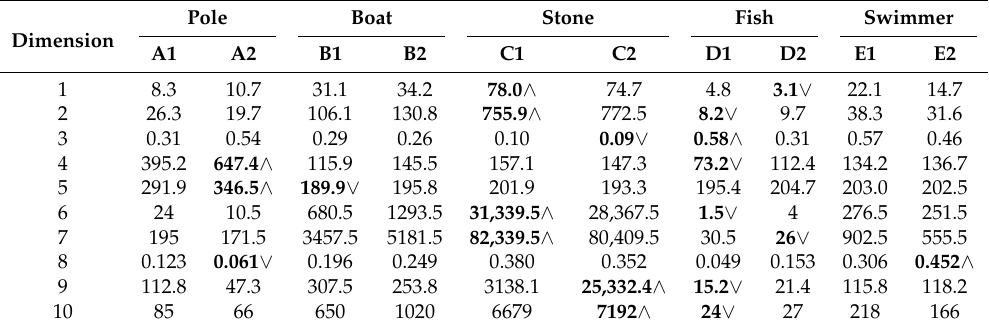
Table 4. Feature values of the segments in Figure 8. In each line, the symbol ( ∧ ) indicates the highest value and ( ∨ ) indicates the lowest value. The highest and lowest values of each segment are bolded. Pole Boat Stone